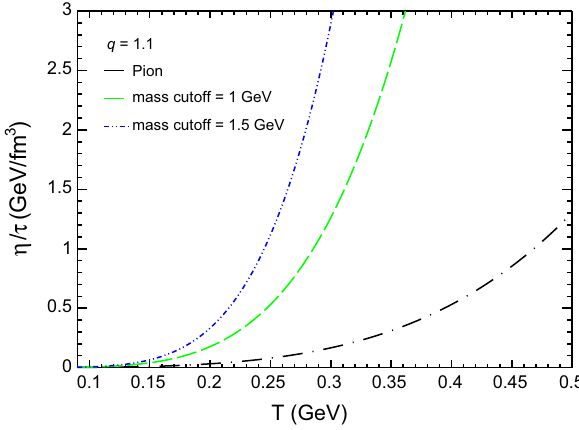
η/τ with q . tion of temperature ( T ) are presented in the top panel of Fig. 3 for various q -values. We find that η increases with temperature in a similar way as observed in Ref. [38], where Excluded-Volume Model with extensive statistics is used.